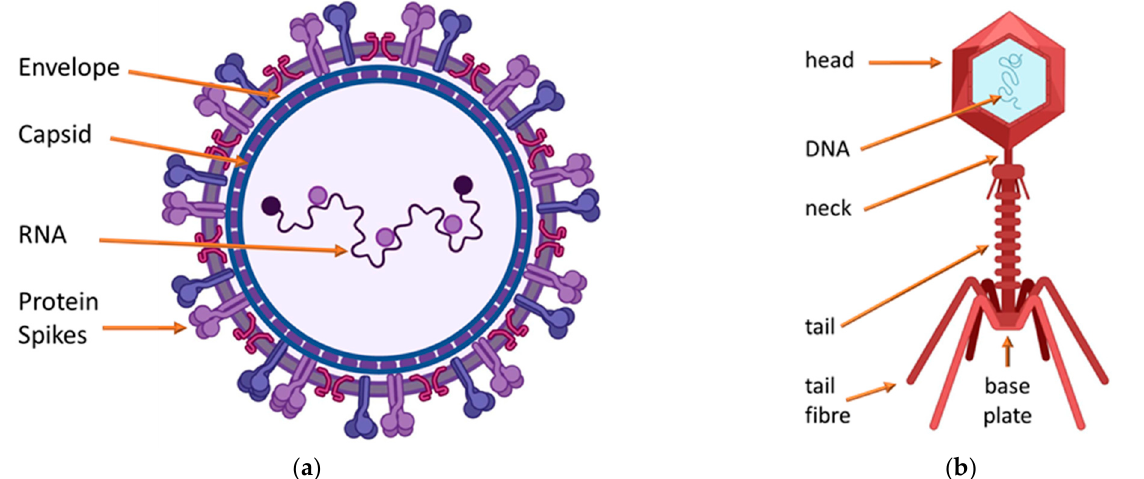
Figure 1. There are two major morphological classes of viruses, the isometric class and the bacteri- ophages. ( a ) Isometric viruses are more or less spherical, ( b ) macrophages are head-and-tail viruses.